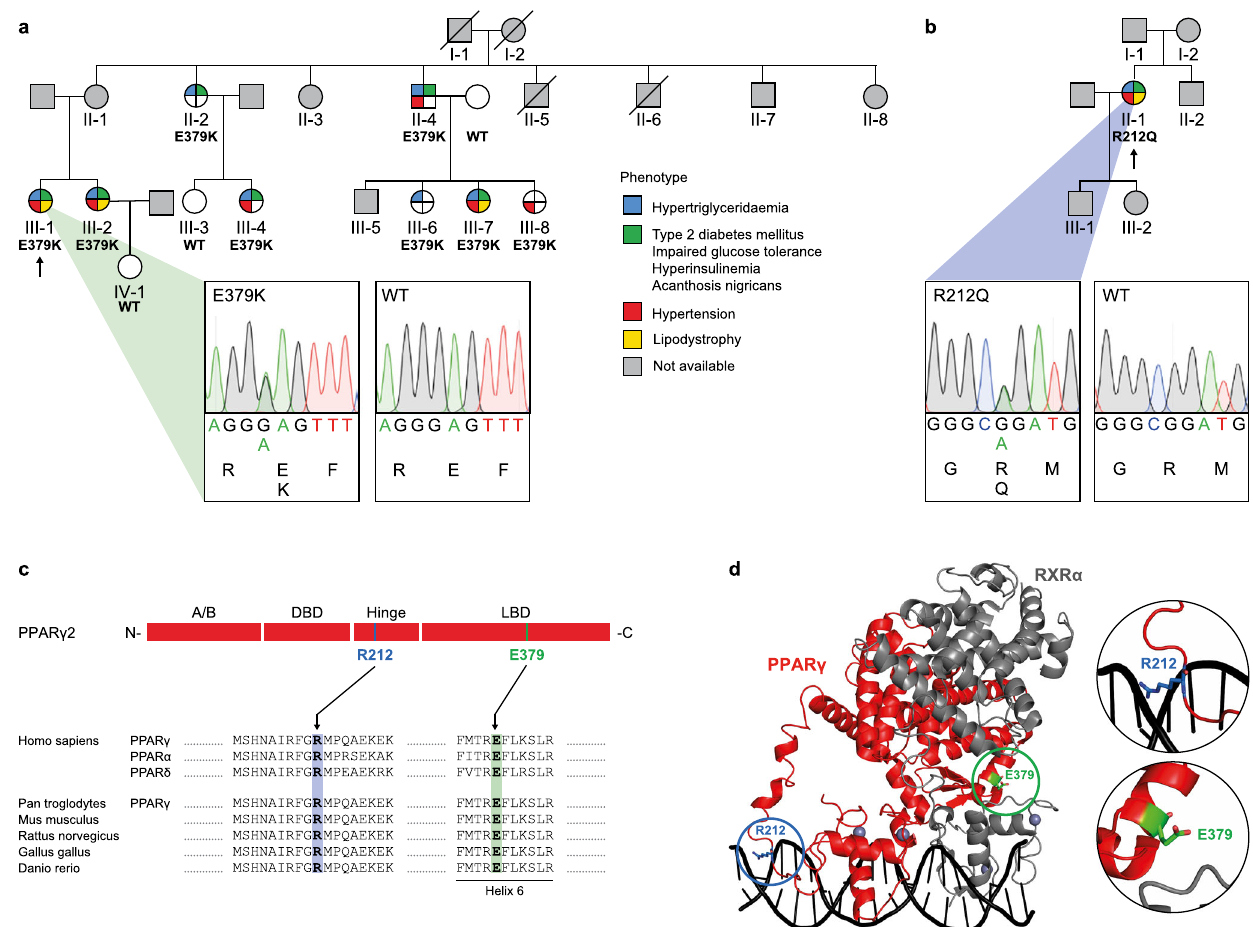
Fig. 1 | Identi fi cation of PPAR γ 2 E379K and R212Q. a Family pedigree of index patient 1. Each family member is numbered for identi fi cation. The proband is indicatedbyanarrow.Squaresandcirclesindicatemalesandfemales,respectively. Phenotypes are elaborated by color segments showing the presence of speci fi c features.GraysymbolsdenoteindividualsthatwerenotavailableforDNAanalysis. Deceased individuals are indicated by a diagonal line through the symbol. DNA sequence analysis showing the heterozygous E379K mutation. The chromatogram shows both alleles from the patient (left panel) in comparison with corresponding genomic DNA from a non-affected individual (right panel). For tracing, the nucleotideandaminoacidsequencesareshown. b Familypedigreeofindexpatient 2,harboring a heterozygous R212Qmutation. See description of panel a fordetails on representation. c Top: Schematic representation of domains in PPAR γ 2; N-terminal A/B-domain, DNA-binding domain (DBD), hinge region, and ligand-